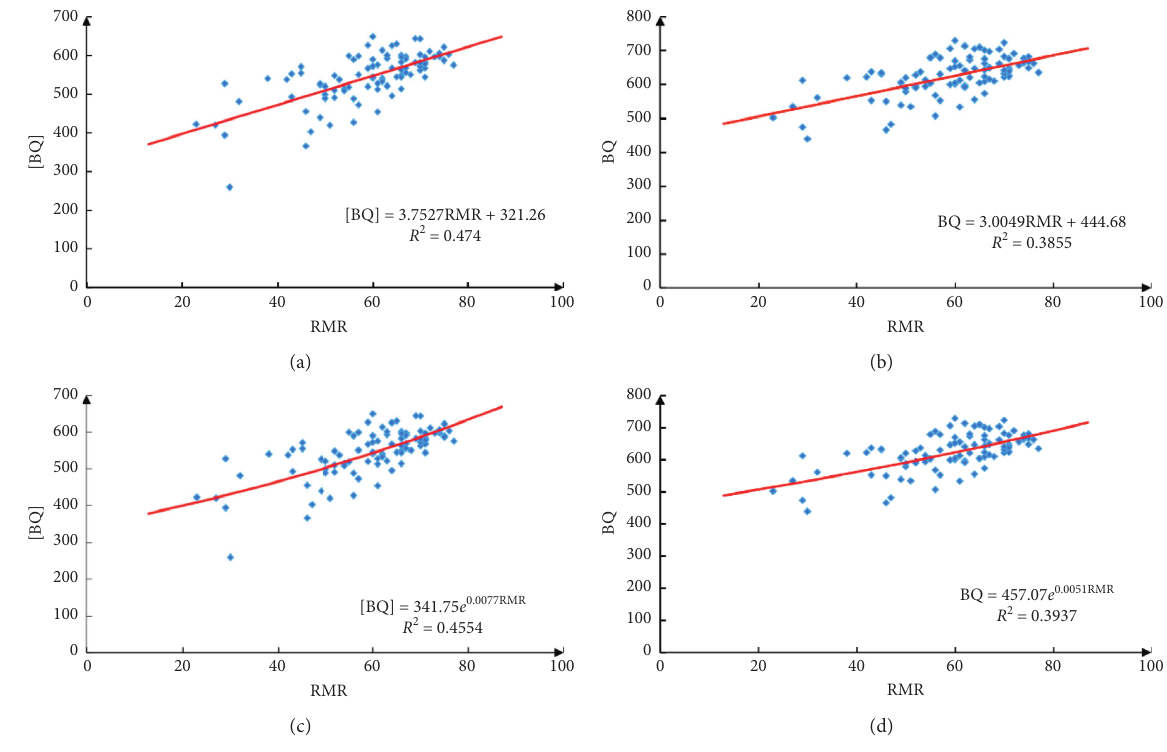
Figure 10: Fitting curve of [BQ]/BQ and RMR, (a) RMR-[BQ] linear fitting straight line, (b) RMR-BQ linear fitting straight line, (c) RMR- [BQ] exponential fitting curve, and (d) RMR-BQ index fitting curve.